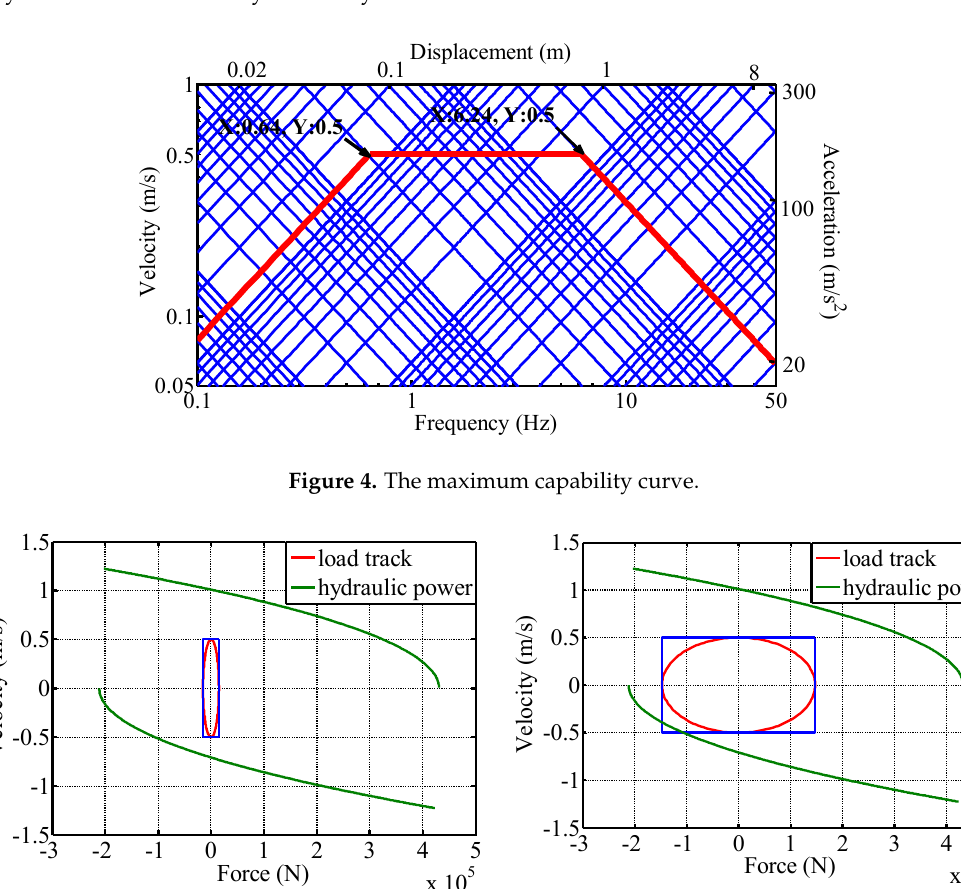
( c ) The schematic of the three ‐ stage servo valve.